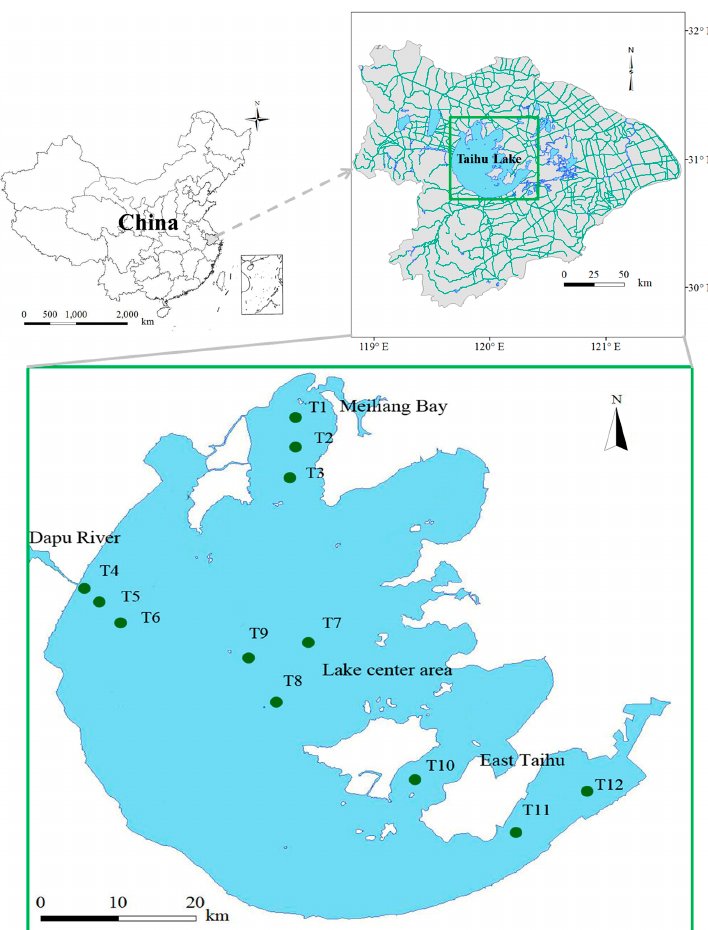
Figure 1. Sampling sites in Lake Taihu: Sites T1, T2 and T3 in Meiliang Bay represent a phytoplankton- dominated zone; Sites T4, T5 and T6 in Dapu River estuary represent an estuary zone; Sites T7, T8 and T9 in the central area of Lake Taihu represent the lake center zone; and Sites T10, T11 and T12 represent a macrophyte-dominated zone. Surface water (~0.5 m depth) was collected directly into acid-cleaned HDPE plastic bottles using